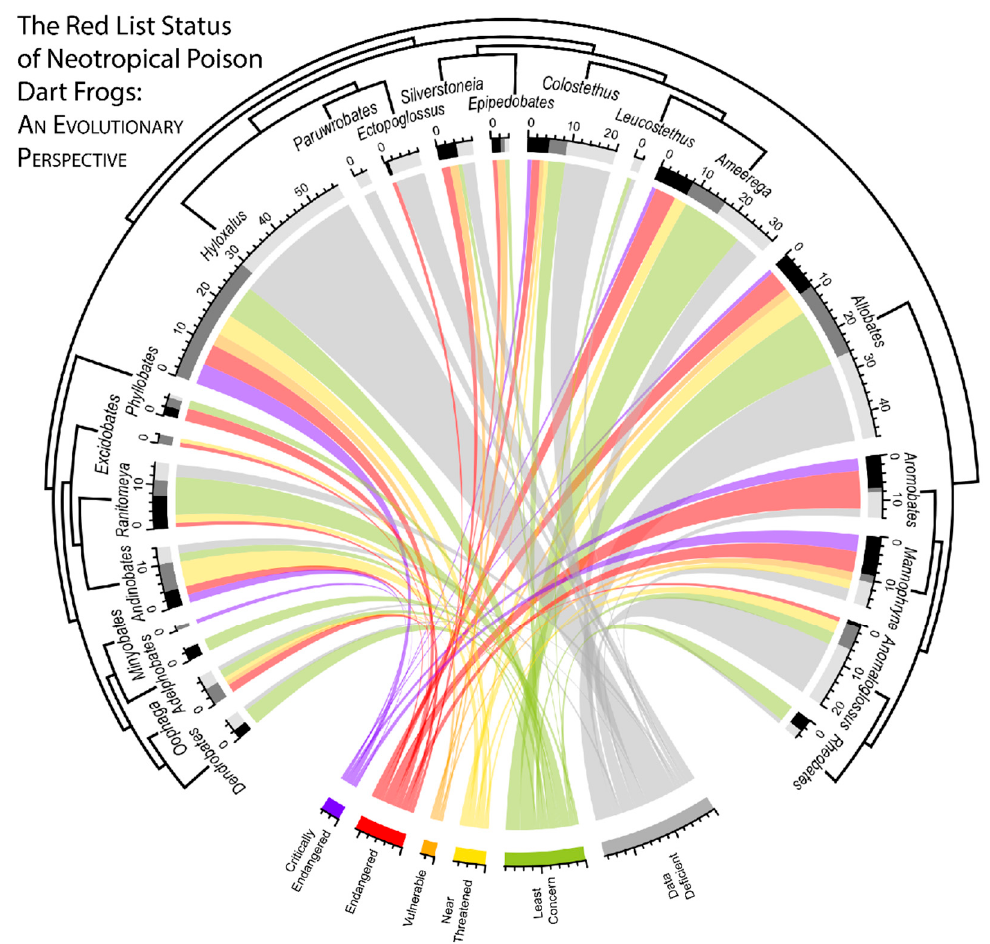
Figure 2. An evolutionary perspective of the Red List status of Aromobatidae and Dendrobatidae. Each species is characterized by a ribbon that is connected to its current Red List status (bottom). The numerical values below each genus depict the number of species with the associated Red List status. Bars on the outer ring depict the current population status of the corresponding genus, either: decreasing, stable or unknown (black, dark grey, or light grey respectively). A tree representing the evolutionary relationships of the genera surrounds the main diagram. Relationships for taxa not included in our study (Dendrobatidae: Paruwrobates, Ectopoglossus, Leucostethus; Aromobatidae: Aromobates, Anomaloglossus, Mannophryne, Rheobates ) are reproduced from Grant et al. 2017 [41] .